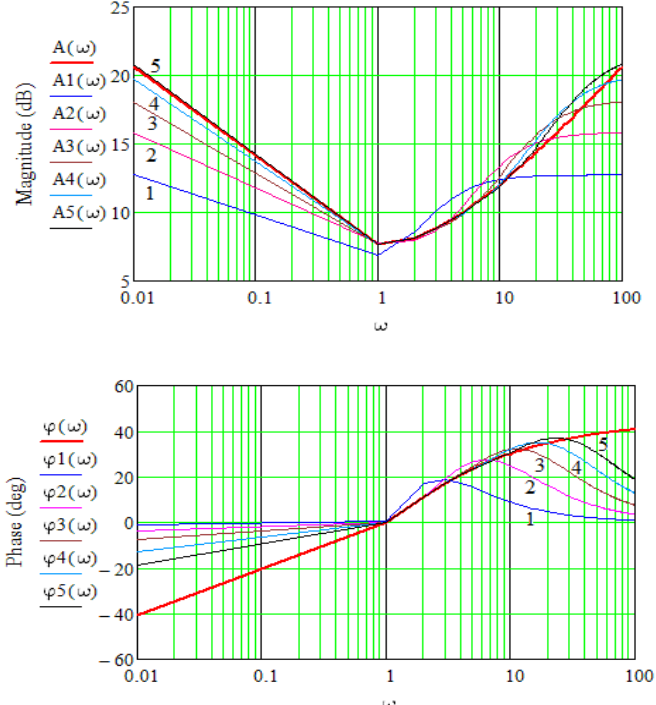
Figure 5. Reference frequency characteristics and frequency characteristics for five approximation orders, if α =±0.5.